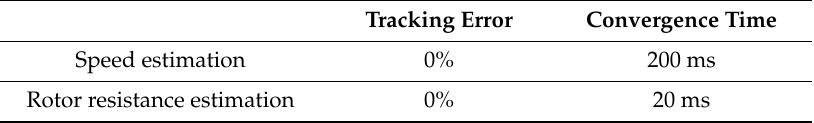
Table 3. Convergence time and tracking error of the proposed